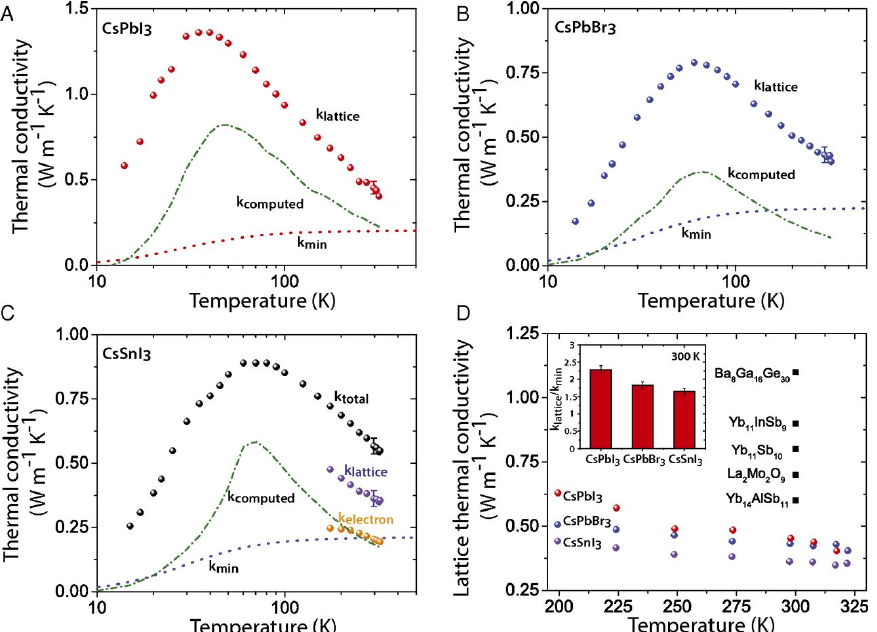
Figure 25. Thermal conductivity of all inorganic perovskite. Measured thermal conductivity ( A − C ) K lattice A, and B, K total in C. CsSnI 3 thermal conductivity is calculated from observed conductivity and Wiedemann–Franz law. K total = K lattice + K electron . ( D ) Comparison with other inorganic single crystal and inorganic materials having ultra-low thermal conductivity. Reproduced with permission [21].